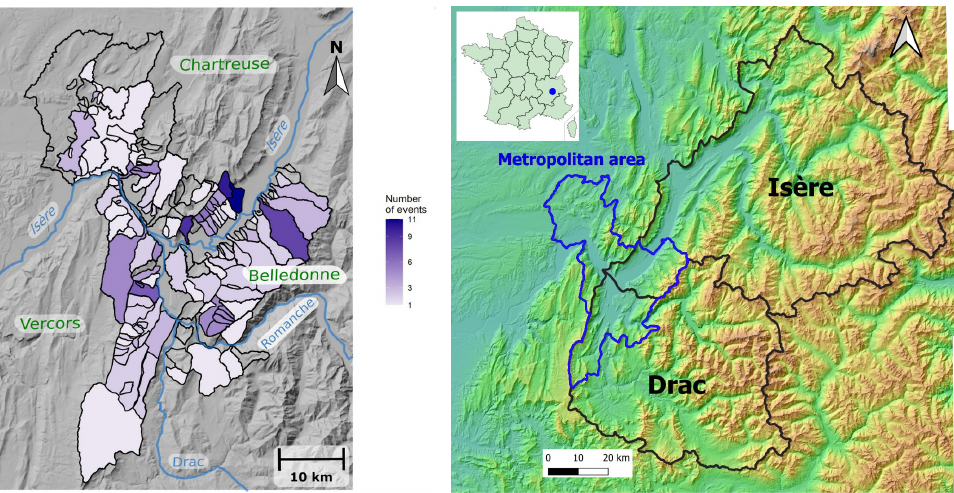
Figure 1. Map ( left ) of the RTM torrential units of the Grenoble conurbation colored according to the number of events observed over the 1850–2019 period. Map ( right ) showing the Metropolitan area nested in the Isère and Drac